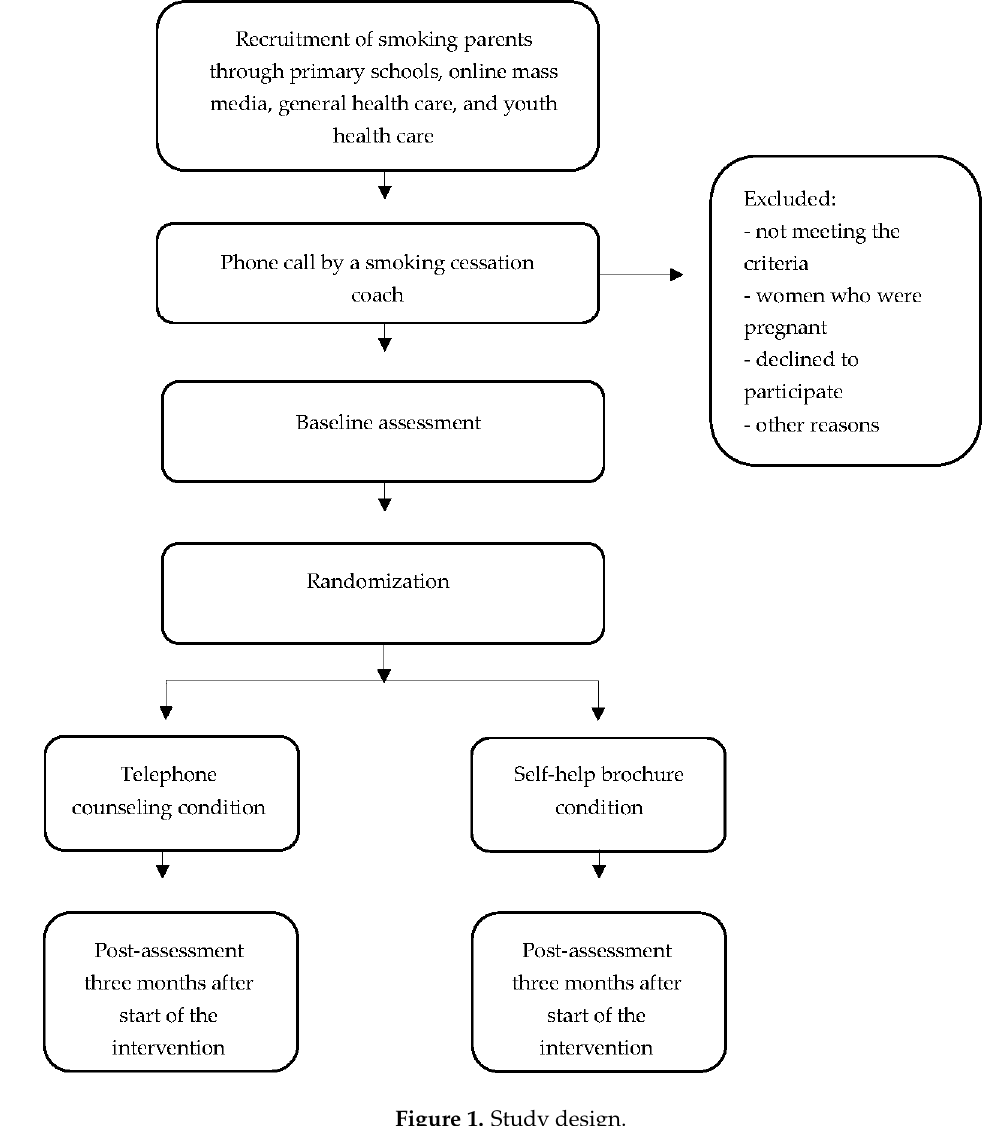
Figure 1. Study Figure 1. Study design.